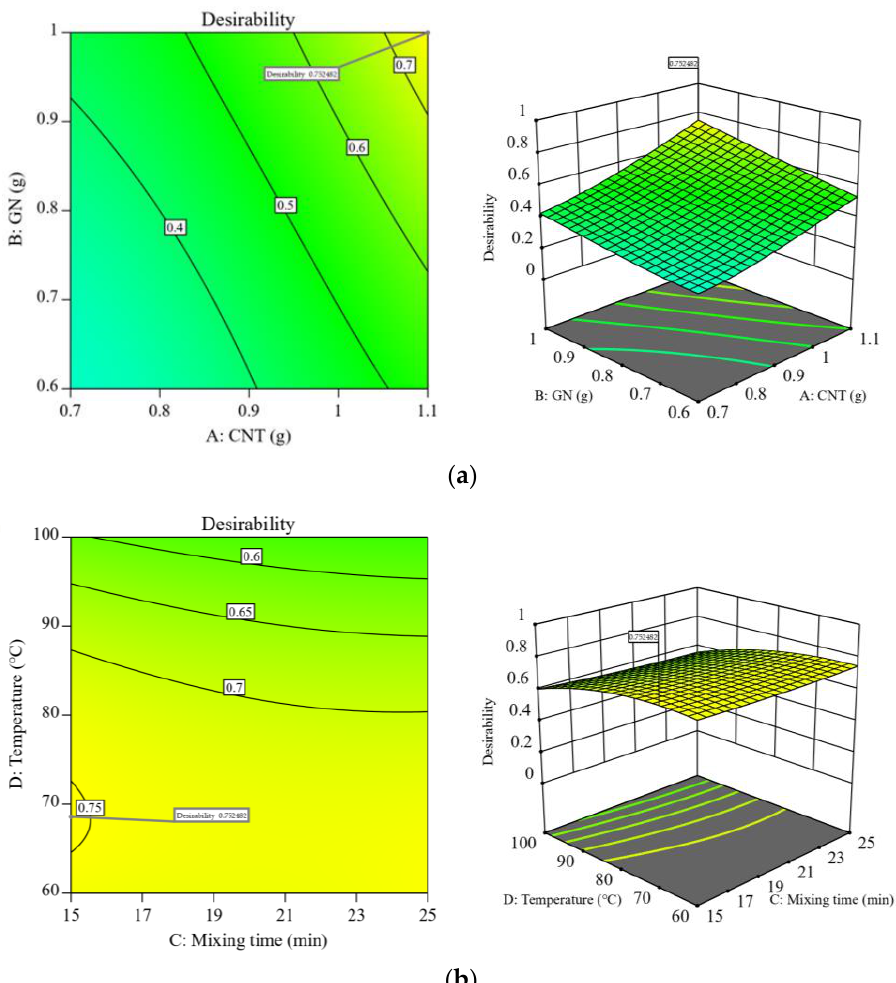
Figure 7. A 3D response surface plot ( a ) with 2D contour plot; ( b ) with a desirability function applied to multiple responses.